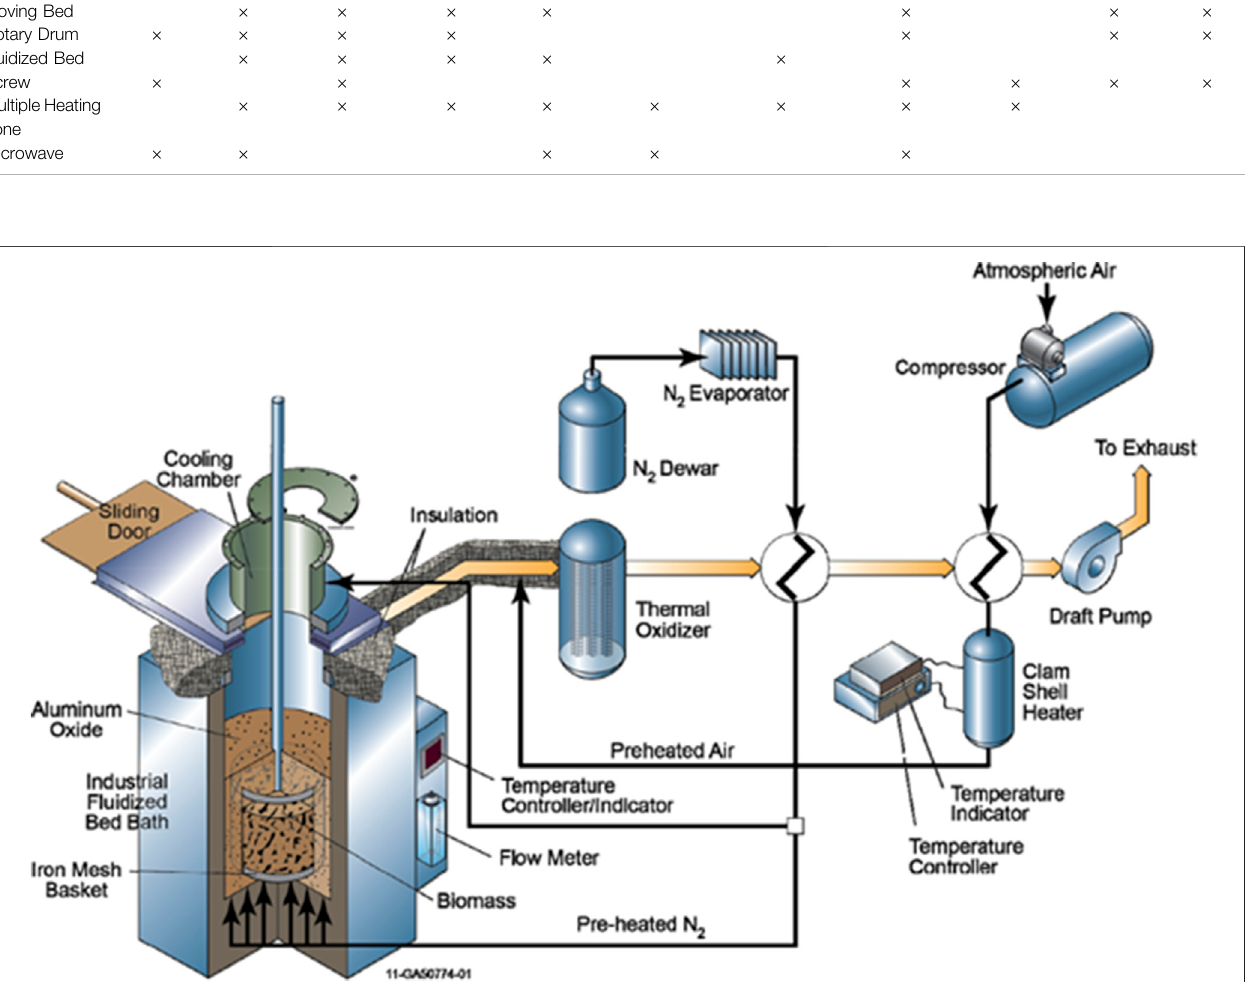
Frontiers in Energy Research |